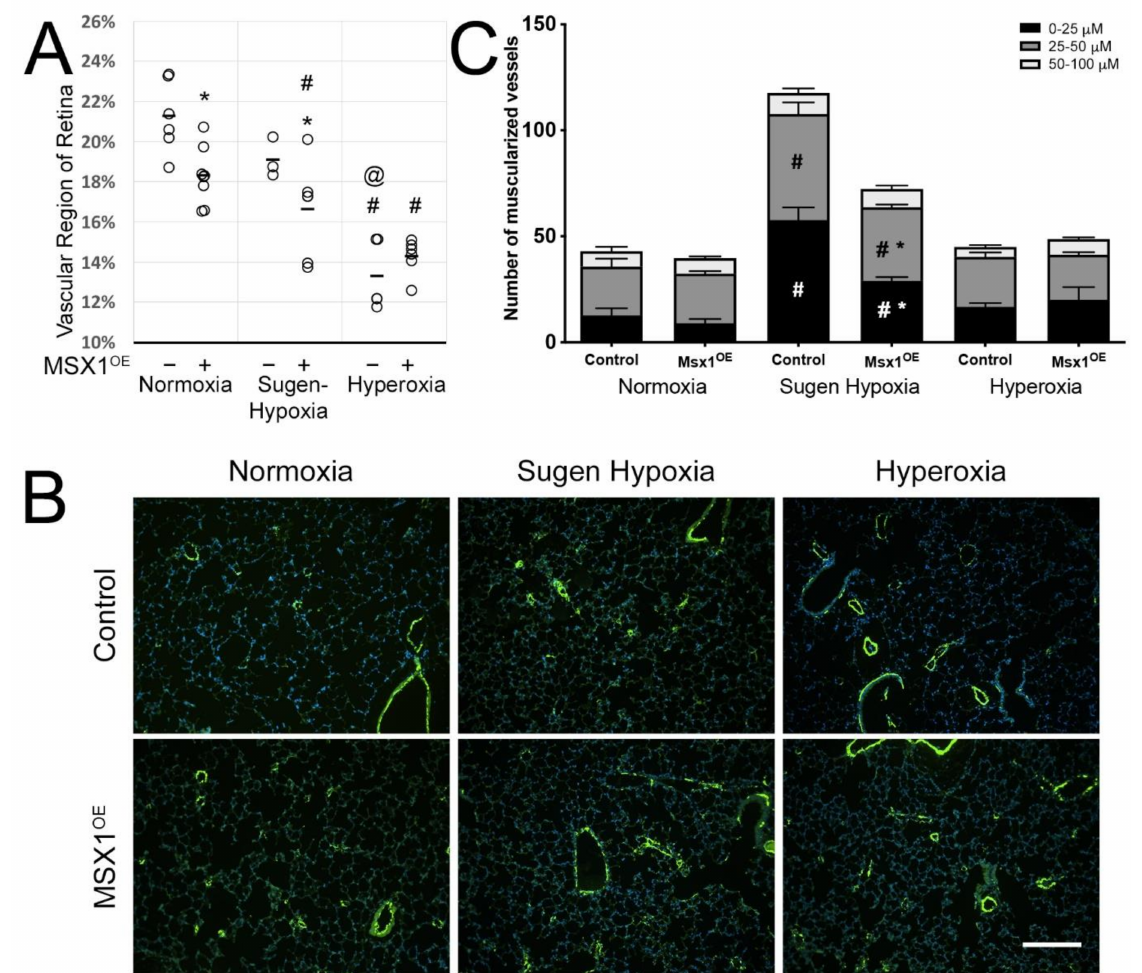
Figure 4. ( A ) Vascular region in the retina is decreased in MSX1 OE mice under normoxic and sugen hypoxia conditions compared to controls. (* p < 0.01—Comparing Control and Msx1 OE mice. # p < 0.03—Comparing Msx1 OE normoxia group mice with Sugen Hypoxia or hyperoxia group mice. @ p < 0.002—Comparing sugen hypoxia group mice with hyperoxia group mice) ( B ) Immunostaining for alpha SMA (pulmonary vessel in green color). Magnification 100 × . Scale bar = 50 µ M. ( C ) In MSX1 OE mice, pulmonary vessels (0–25 µ M and 25–50 µ M in size) were decreased compared to controls following sugen hypoxia treatment ( n = 3). (# p < 0.02—Comparing control and Msx1 OE mice from normoxia group with sugen-hypoxia group, respectively. * p < 0.05—Comparing control and MSX1 OE mice in sugen-hypoxia